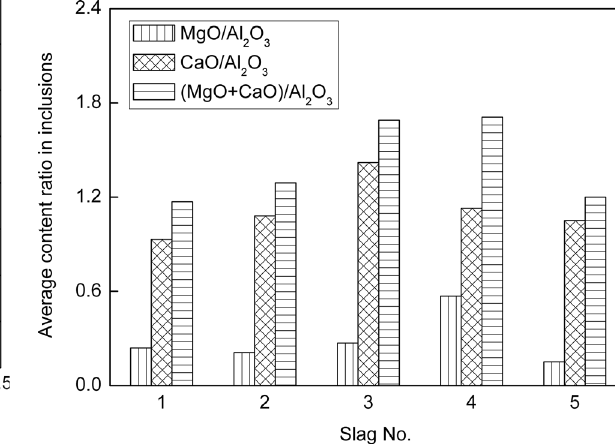
Figure 10 : Composition of inclusions, log ( X MgO / X Al2O3 ) as a function of log ( a MgO / a Al2O3 ) at 1,823 K [17]. Figure 11 : The average content ratio of inclusions under the five slag